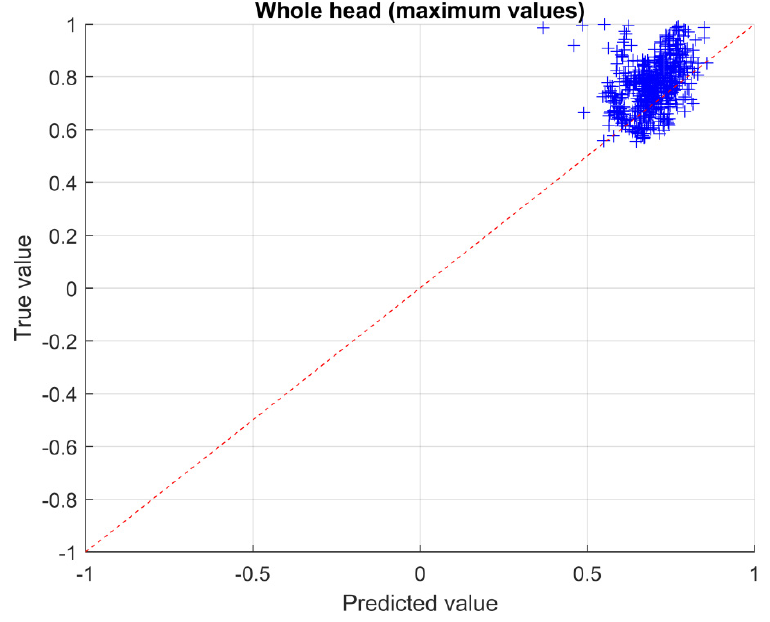
Figure 12. True vs. predicted values for the head region (maximum values).